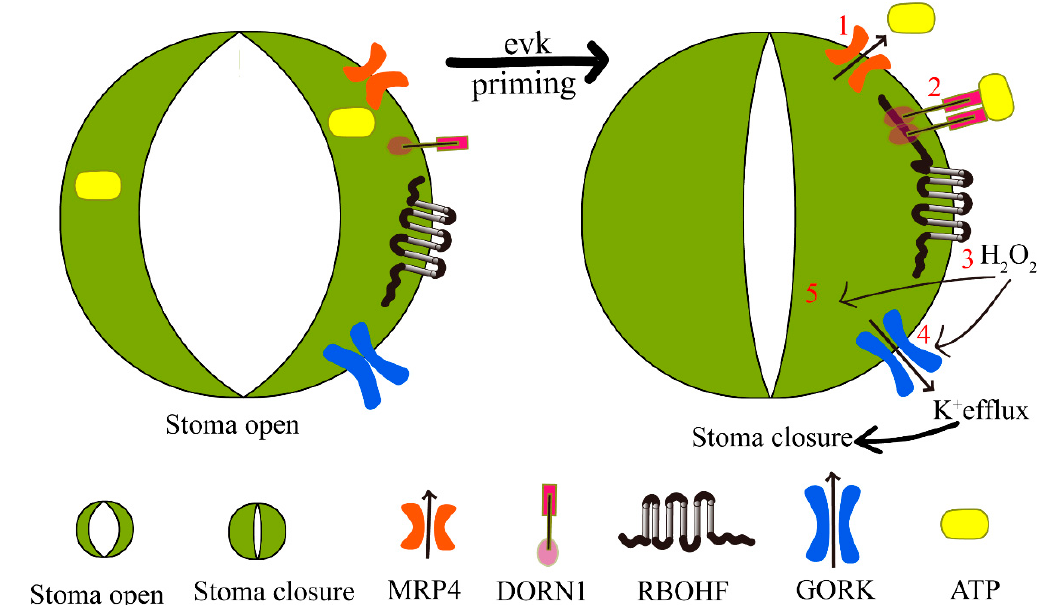
Figure 8. The proposed model depicting the mechanism of evk-induced stoma closure. The green part is kidney-shaped cells, which are surrounded by two kidney-shaped cells to form the organ stomata. Evk, as a signal substance, plays an early warning role, thus causing stomata to close. ( 1 ). Evk-induced eATP accumulation by MRP4; ( 2 ). eATP receptor DORN1 accepted eATP; ( 3 ). DORN1 regulate RBOHF to burst H 2 O 2 ; ( 4 ). H 2 O 2 regulates K + efflux to cause stoma closure ( 5 ).